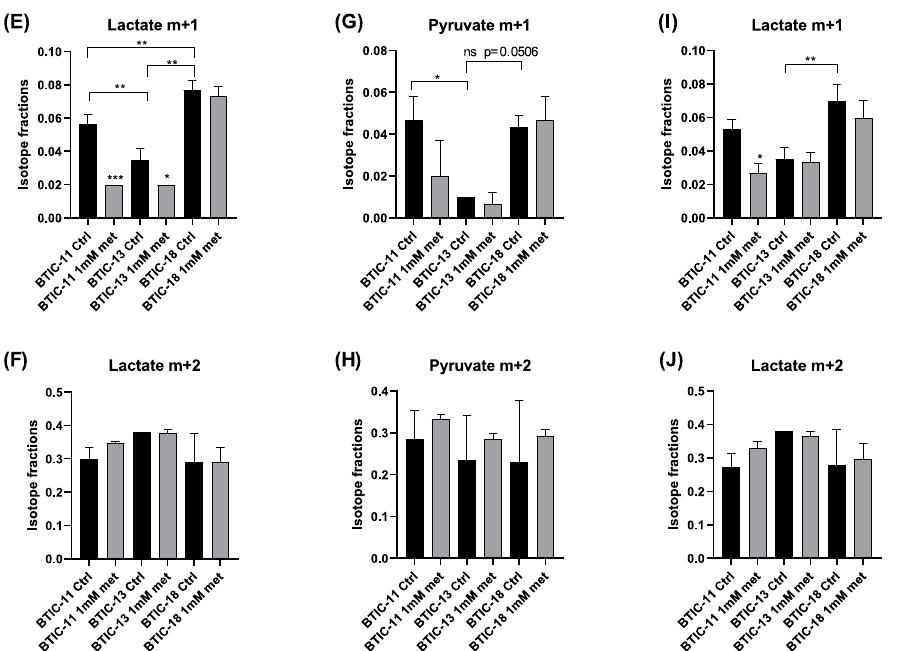
Figure 6. Activity of glycolytic enzymes and lactate tracing with [ 13 C 2 -1,2]glucose. ( A ) Diagram depicting [ 13 C 2 -1,2]glucose metabolism through glycolysis and the pentose phosphate pathway (PPP) and the resulting labeling patterns of key intermediates and lactate. Glycolysis will result in the formation of one molecule each of [ 13 C 2 -2,3]lactate and [ 12 C 3 ]lactate from one molecule of [ 13 C 2 -1,2]glucose, while the PPP will convert three molecules of [ 13 C 2 -1,2]glucose into one molecule each of [ 13 C 2 -1,3]lactate and [ 13 C 1 -3]lactate and three molecules of [ 12 C3]lactate. The relative abundances of PPP-derived [ 13 C 1 -3]lactate (lactate m + 1) and glycolytic [ 13 C 2 -2,3]lactate (lactate m + 2) provide estimates of PPP and glycolytic activity, respectively. Key enzymes of glycoly- sis and the pentose phosphate pathway are depicted in the graph. G6P = glucose 6-phosphate; X5P = xylulose 5-phosphate; G6PDH = glucose-6-phosphate dehydrogenase; E4P = erythrose 4-phosphate; F6P = fructose 6-phosphate; F1,6BP = fructose 1,6 bis-phosphate; GAP= glyceralde- hyde 3-phosphate. Red filled circles denote carbon 13, black unfilled circles denote carbon 12. ( B ) Hexokinase activity was significantly lower in proneural BTIC-8 and -18 than mesenchymal BTIC-11 and -13, while ( C ) the opposite applied to G6PDH activity. ( D ) Phosphofructosekinase activity corresponded partly to hexokinase activity. ( E ) The proneural BTIC-18 contained significantly more PPP-derived [ 13 C 1 -3]lactate (lactate m + 1, lactate derivative containing only C2 to C3) than